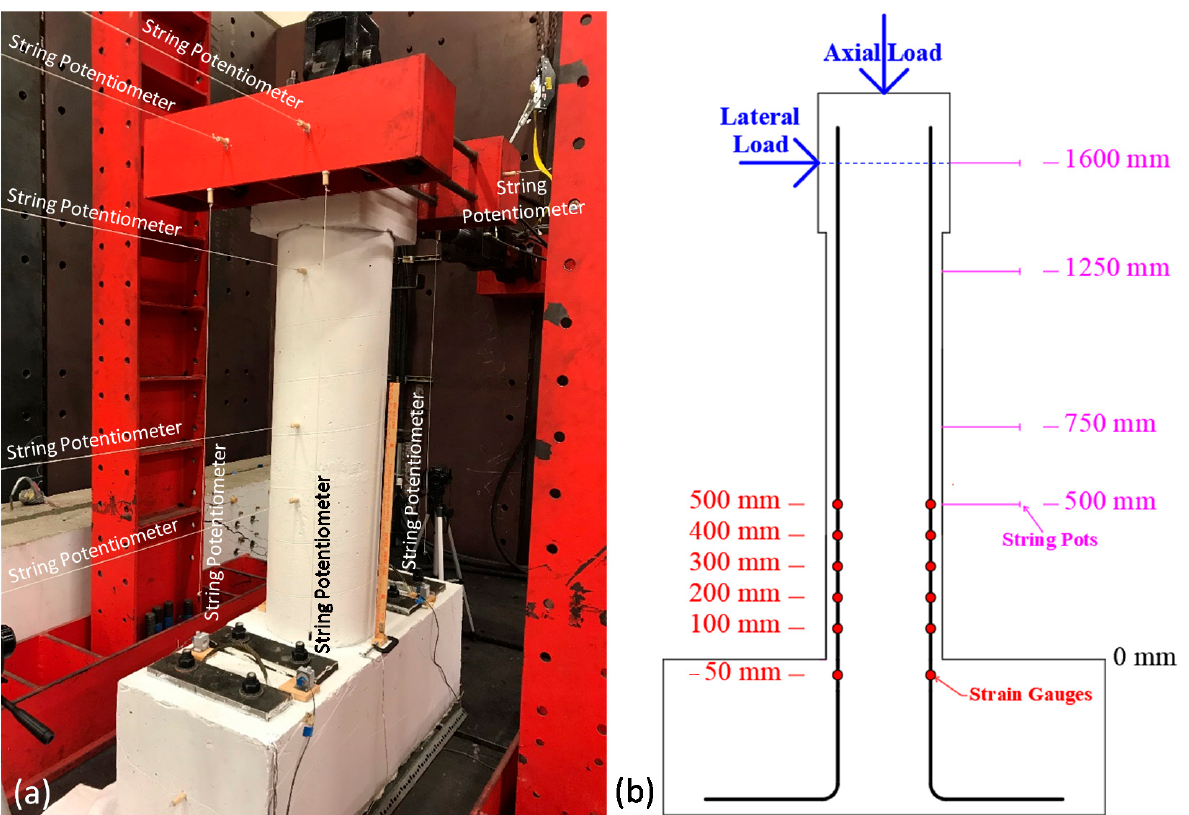
Figure 6. Column instrumentation ( a ) actual and ( b ) schematic with locations.